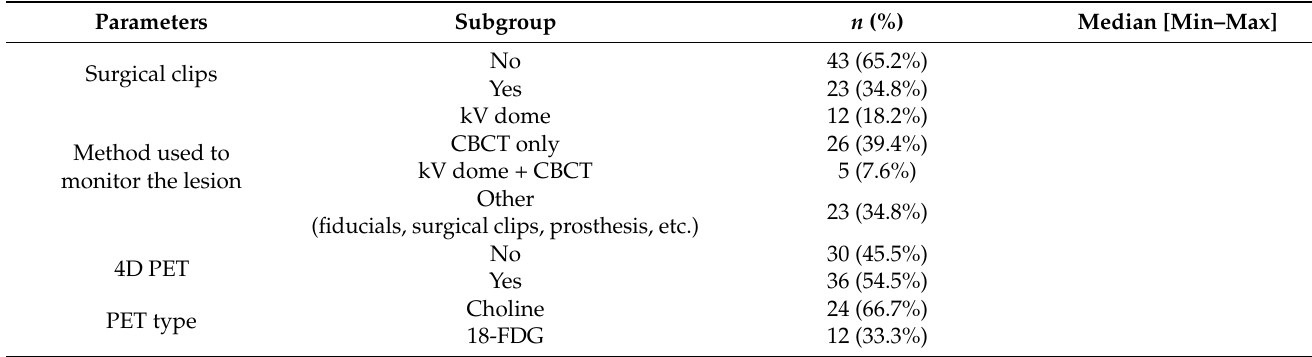
Table 3. Dosimetric